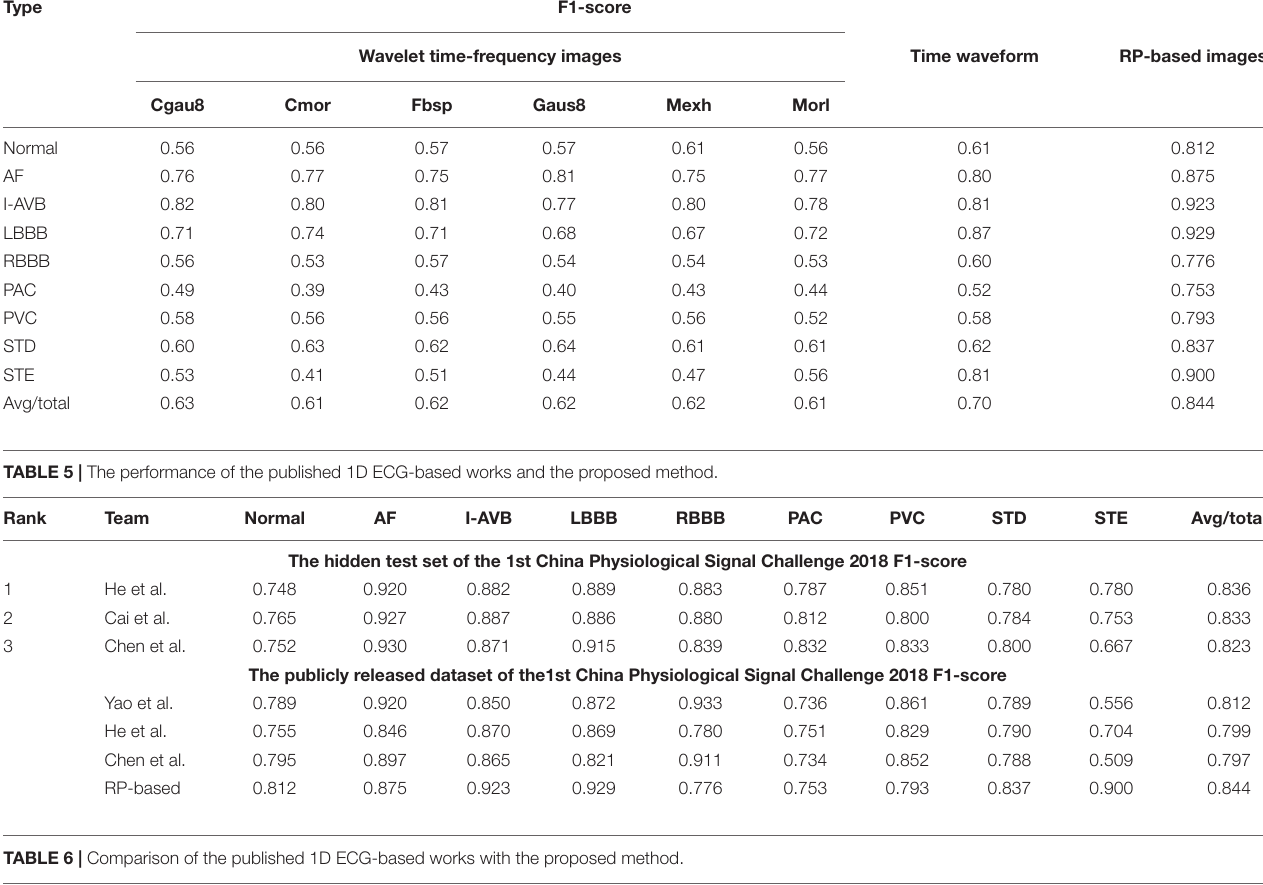
TABLE 4 | Classification performance of different 2D images-based input data. Type